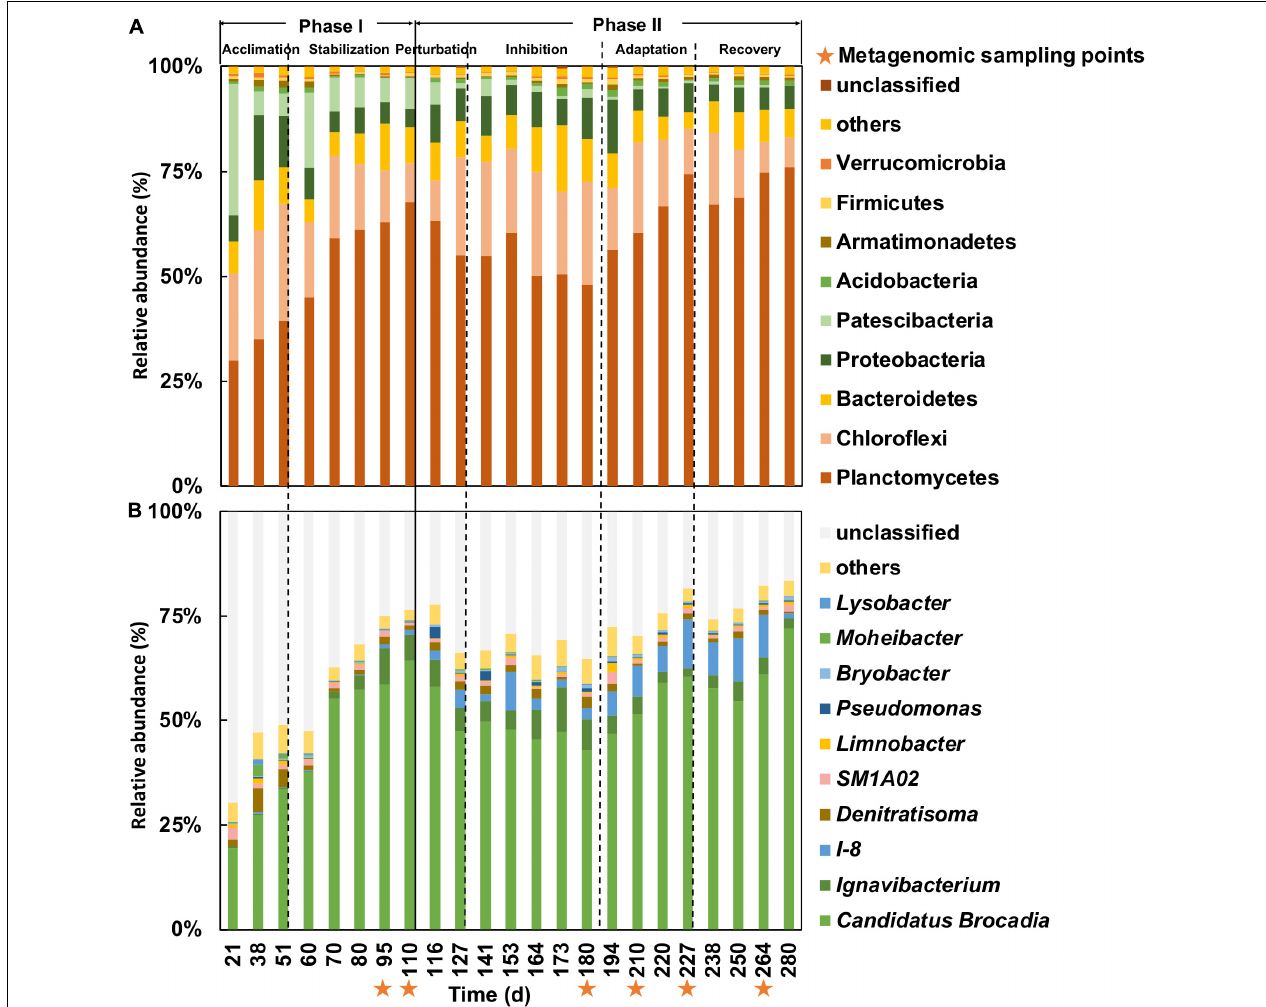
FIGURE 2 | Composition of bacterial community at phylum (A) and genus (B) levels in samples over lifespan of bioreactor based on 16S rRNA OTUs. Orange stars below x-axis indicated sampling time points for metagenomics analysis.